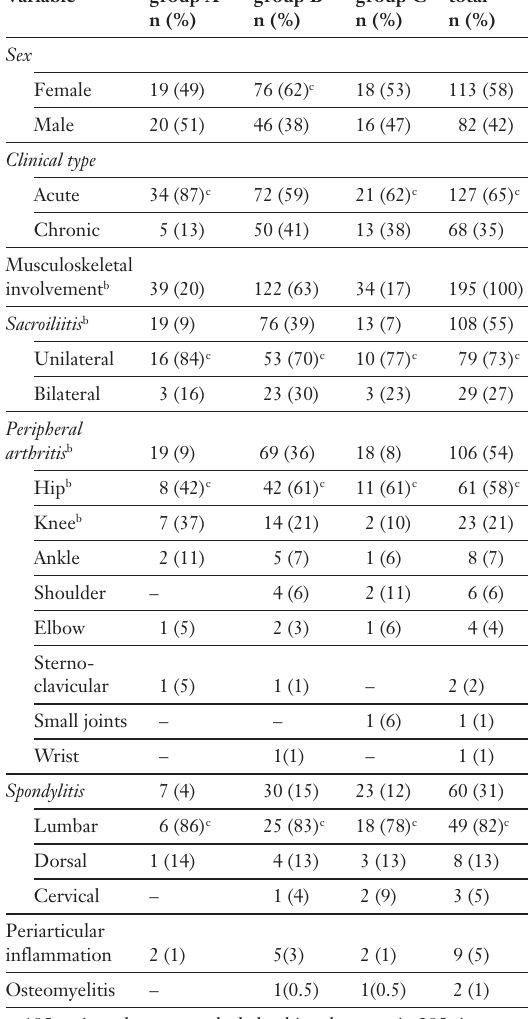
Sites and rates of involvement in the 195 patients with musculoskeletal involvement. a